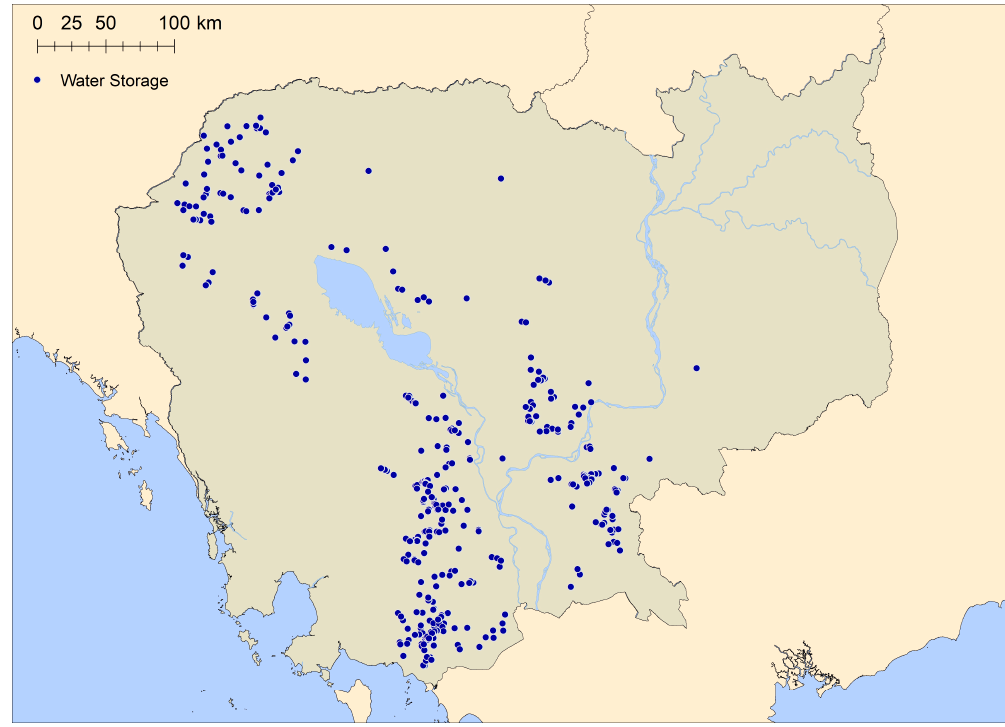
Figure 6. Water Storage features identified using 1979 imagery.